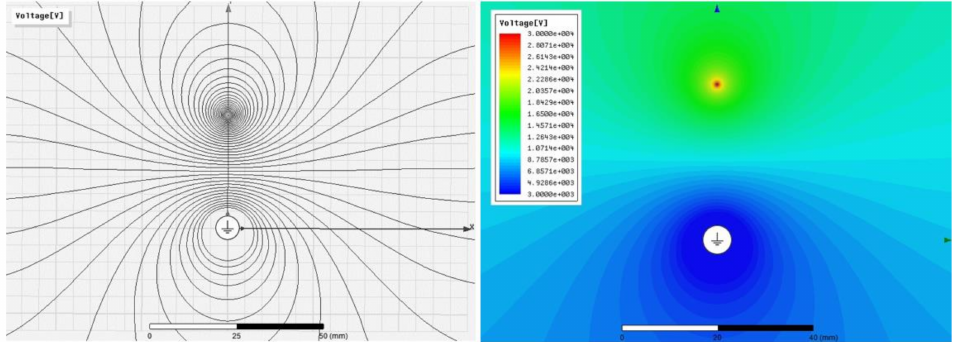
Figure 8. Single thruster, potential distribution between emitter and collector.